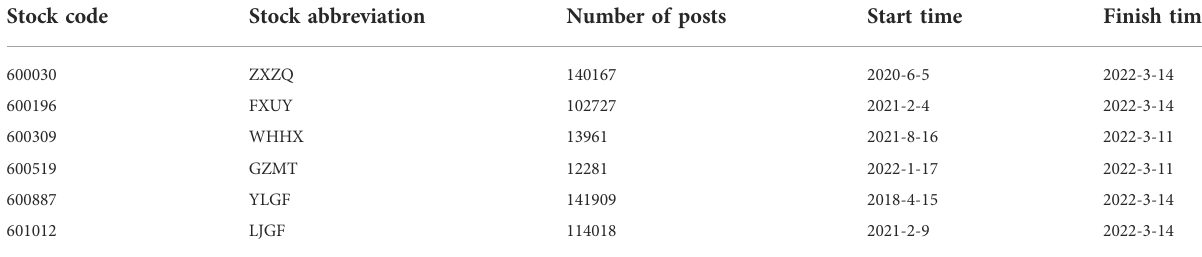
TABLE 2 Data sample